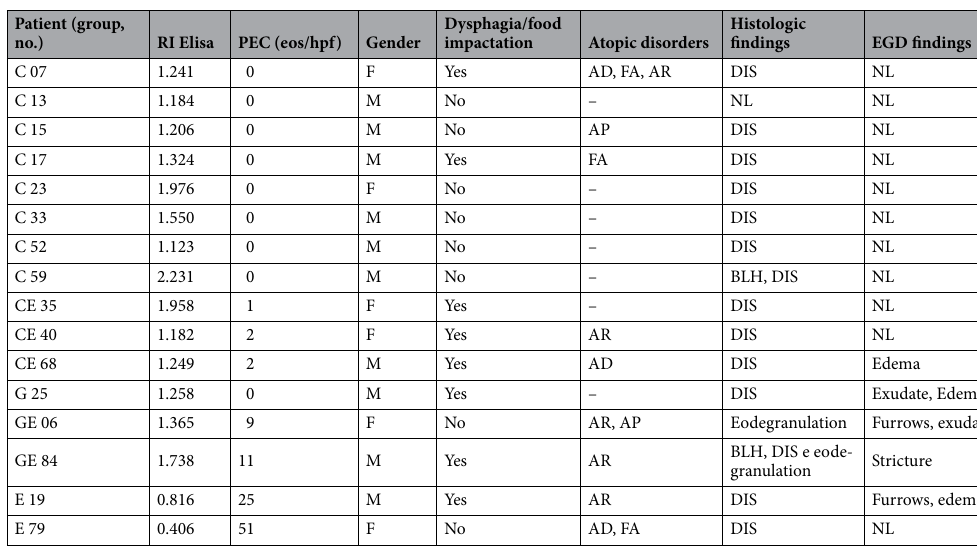
Table 2. Features suggestive of EoE present in patients non-EoE with RI ≥ 1 and in EoE with RI ≤ 1. C control without eosinophils, CE control with ≤ 15 eosinophils/hpf, G gastroesophageal reflux disease without eosinophils, GE gastroesophageal reflux disease with ≤ 15 eosinophils/hpf, E eosinophilic esophagitis, AD atopic dermatitis, FA food allergy, AR allergic rhinitis, AP atopic parents, DIS dilated intercellular spaces, BLH basal layer hyperplasia, Eo eosinophil, EGD esophagogastroduodenoscopy, PEC peak eosinophil counts, eosinophils/hpf, NL normal, M male, F